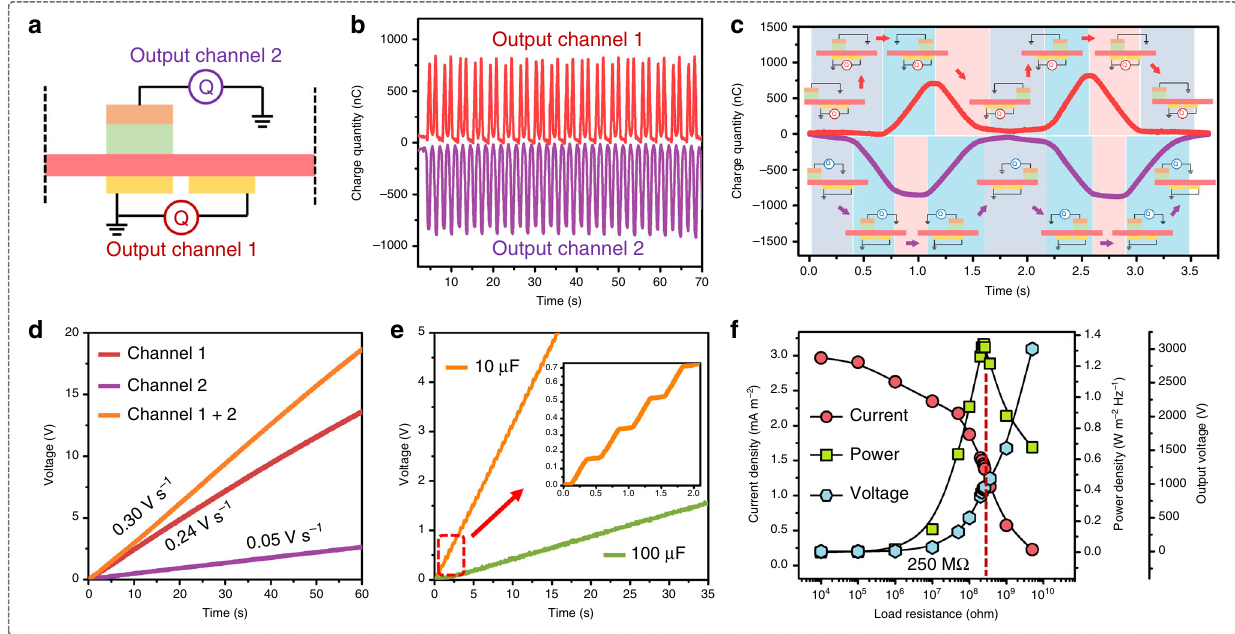
Fig. 3 Performance of double output channel in CSA-S-TENG. a Test schematic of the double output channel. b Simultaneously recorded output charge from channel 1 (red) and channel 2 (purple). c Enlarged output charge curves and corresponding working process of two channels during one sliding cycle. d Voltage curves of charging 10 μ F capacitor at 1 Hz using channel 1, channel 2 and both. e Use channel 1 for charging 10 and 100 μ F capacitor at 1 Hz individually; inset shows the enlarged step-like charging character. f Matching impendence measurement of electrodes between the shielding electrode and the ground during operation period, which indicates that the shielding electrode could contribute to the whole electric output performance of CSA-S-TENG as an independent channel. Here, as schematically shown in Fig. 3a, we set the bottom electrodes and shielding electrode as output channel 1 and output channel 2 respectively, and measured their output charge during sliding cycles simulta- neously. The recorded output charge curves are presented in Fig. 3b. Experimental results verify that nearly same amount of opposite sign (phase) charges are generated from channel 1 (830 nC) and channel 2 (850 nC), which is highly consistent with